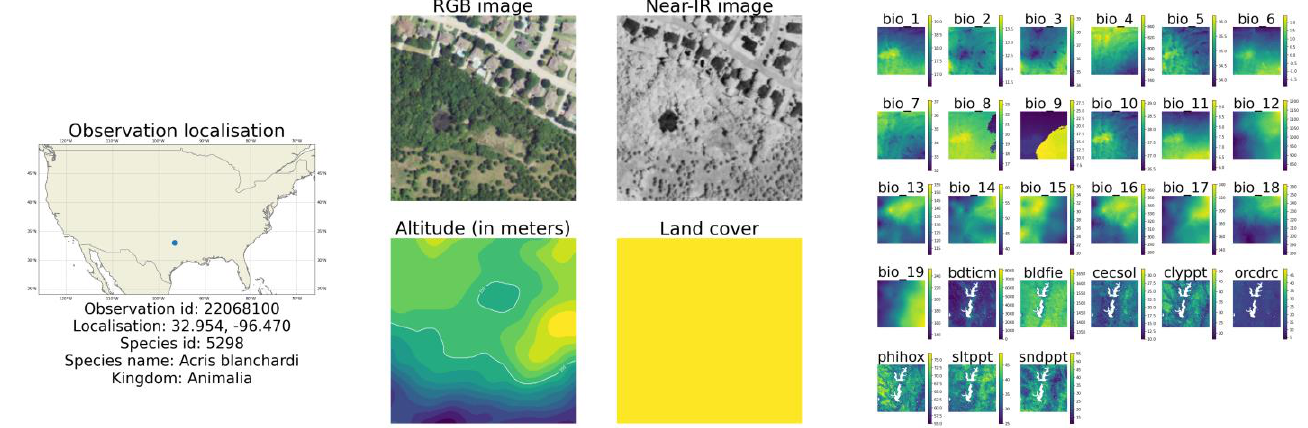
Figure 5. The observation data of the location [32.957, − 96.470] in GeoLifeCLEF 2022.